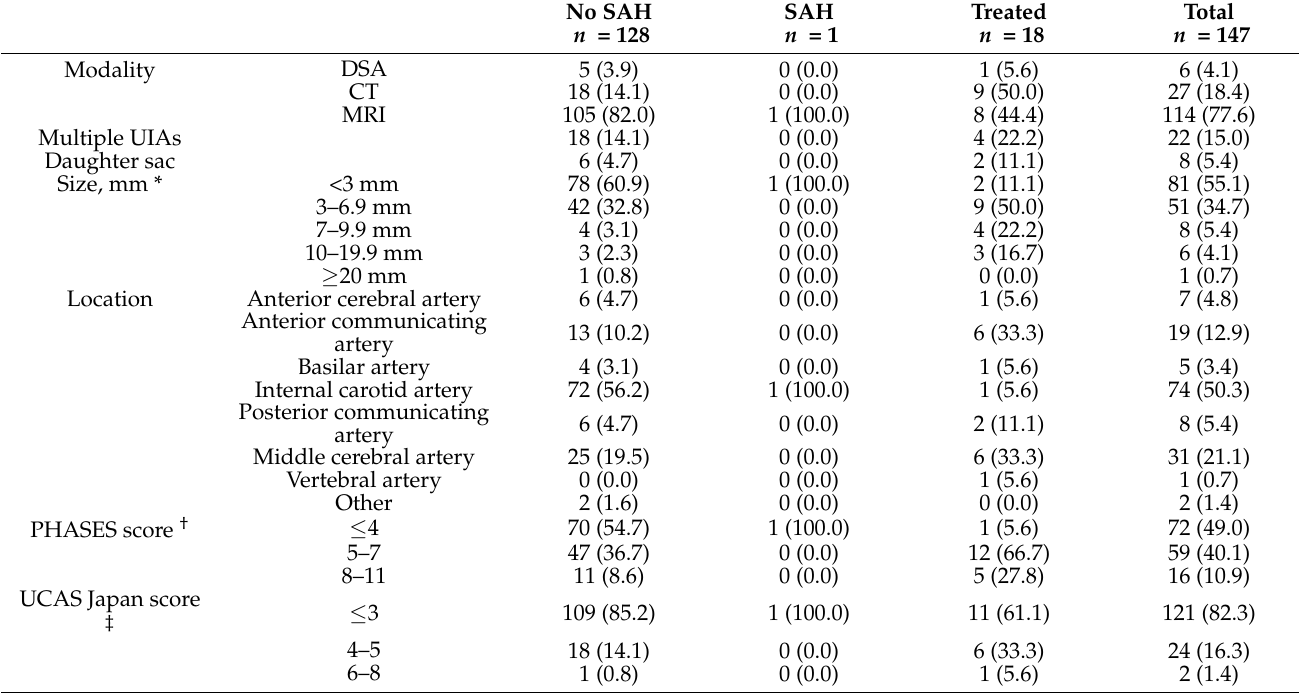
Table 2. Unruptured intracranial aneurysm (UIA)